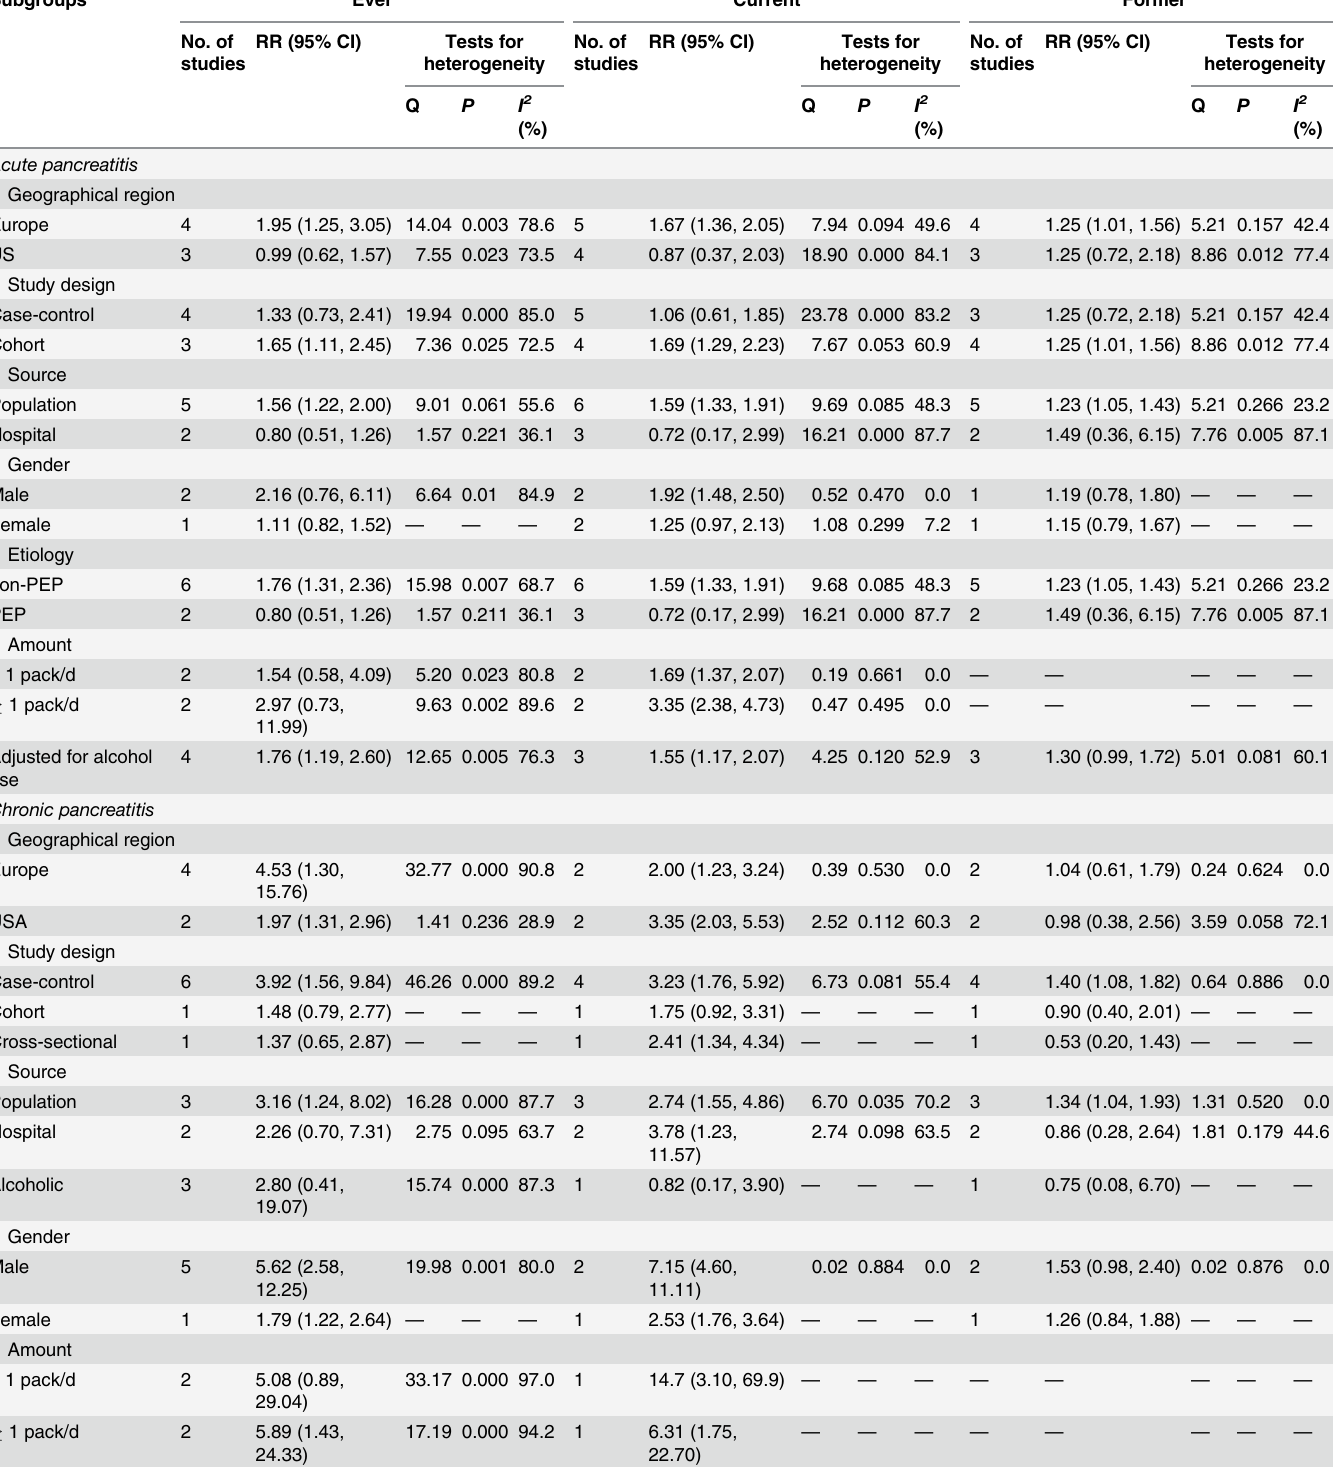
Table 3. Subgroup analyses for the correlation between smoking and